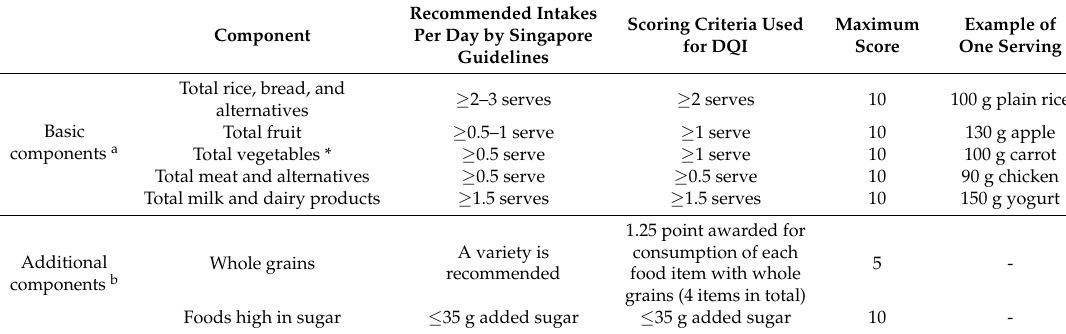
Table 1. Recommended intakes of food groups from the Singapore dietary guidelines for 1 to 2 years old and standards for scoring used for individual DQI